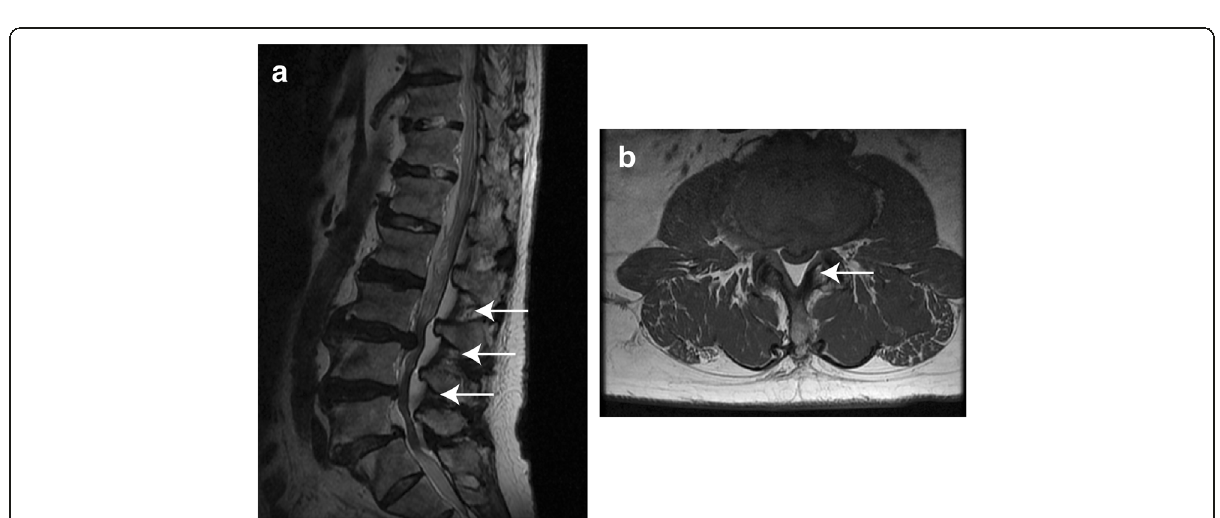
Fig. 2 Magnetic resonance imaging T1 weighted view. a A sagittal scan shows hypertrophy of epidural fat predominately located posterior from L5 to S1 level. b A axial scan of L3-L4 revealed excessive amount of fat within the epidural space compressing the thecal sac. A high signal intensity lesion corresponds to fat ( white arrows